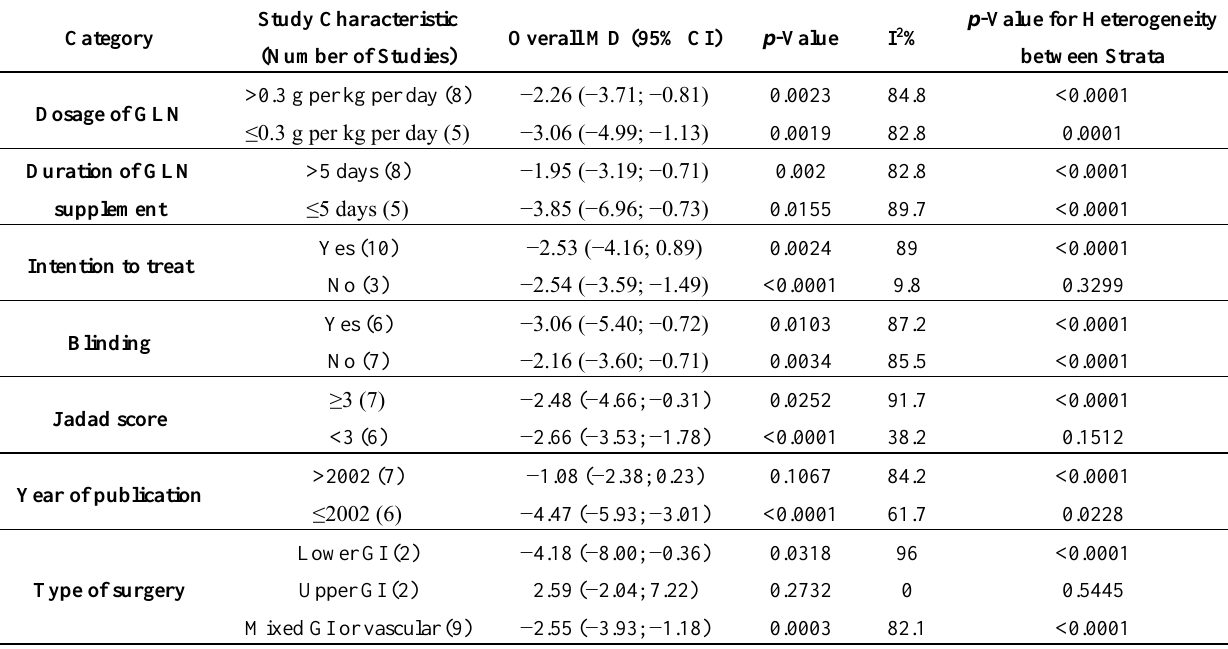
Table 4. Stratified analysis for length of hospital stay comparing GLN vs.